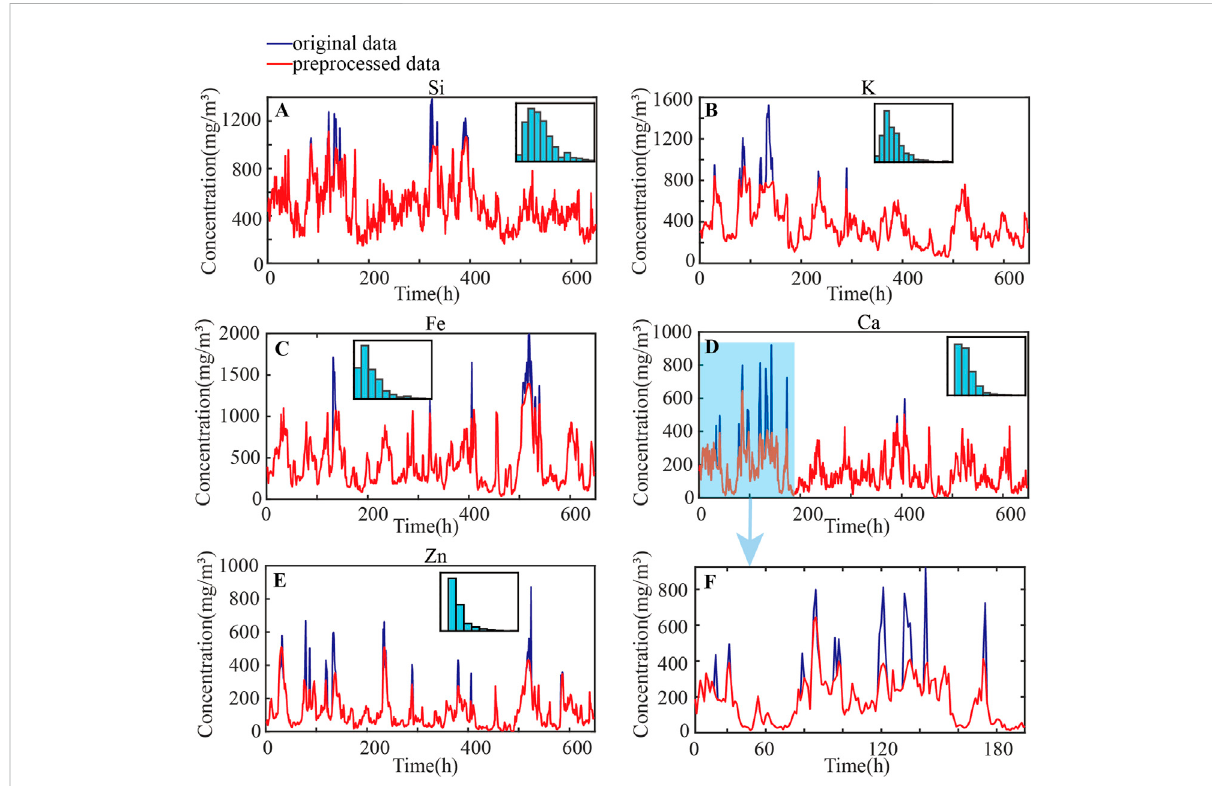
FIGURE 7 Preprocessingofoutliersfromrawchemicaldata. (A – E) showthechangesintheconcentrationvalueswithtime(648 hforeach)ofSi,K,Fe,Ca, andZnbeforeandafterpreprocessing,respectively;thesubplotsof (A – E) showtheconcentrationdistributionofSi,K,Fe,Ca,andZn,respectively; (F) is the local zoom of (D)